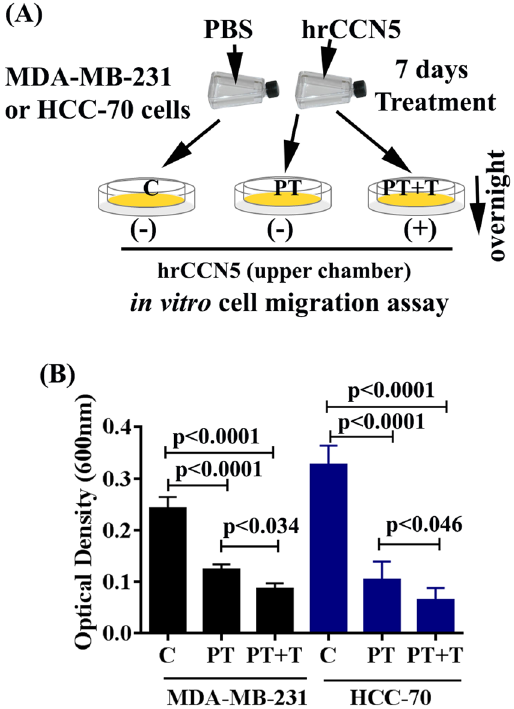
Figure 3. CCN5 treatment prevents in vitro migration of TNBC cells. ( A ) The schematic representation of experimental design. Cells were treated with hrCCN5 (250 ng/ml) or vehicle for 7 days and then cells (10,000 cell/well) were seeded on the upper chamber of the modified Boyden chamber in the presence (PT + T) or absence (C or PT) of hrCCN5 for overnight migration towards serum. C, control, T, treatment and PT, pre- treated. Individual figures (i.e., T-flask and petri-disk) were obtained from ScientificSlides suite, a Microsoft PowerPoint based software. ( B ) The bar graph represents the quantification of migration efficiency in hrCCN5- treated and untreated groups. The extent of migration was measured according to the protocol indicated in the Materials and Methods section. Data show mean ± SD, and are representative of at least three independent experiments. Statistical significance was determined using two-tailed unpaired Student’s